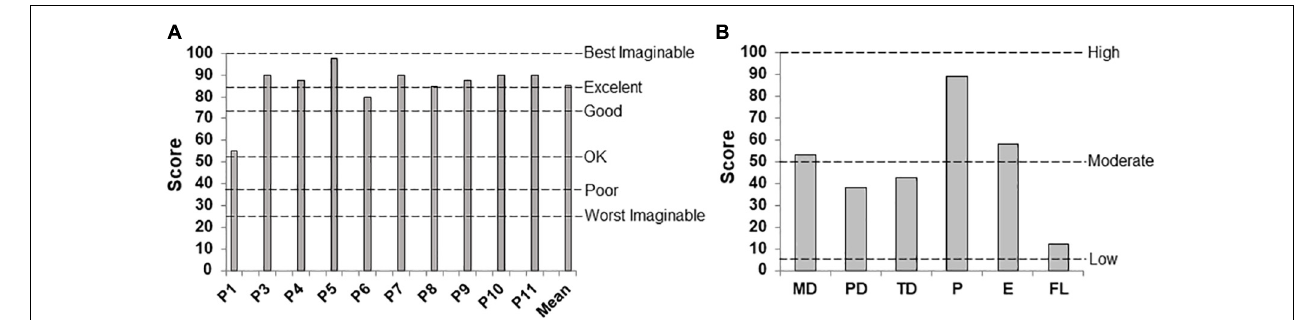
FIGURE 8 | User experience after concluding the BCI intervention. (A) System Usability Scale and (B) NASA-TLX, showing averaged scores assigned to the factors of Mental Demand (MD), Physical Demand (PD), Temporal Demand (TD), Overall Performance (P), Effort (E), and Frustration Level (FL).